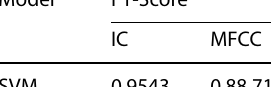
Table 3 Comparison of F1-Score of each model in dataset IC and MFCC